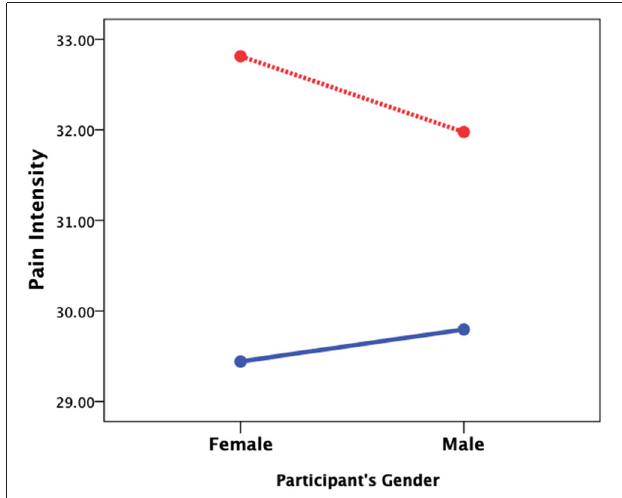
FIGURE 2 | The effect of gender . A 2 (target’s gender) × 2 (perceiver’s gender) ANCOVA controlling for age and years of medical experience revealed that female patients (red line) are usually perceived as experiencing more severe pain and that female physicians perceive stronger pain when the patient is also a female than when it is a male patient (blue line).